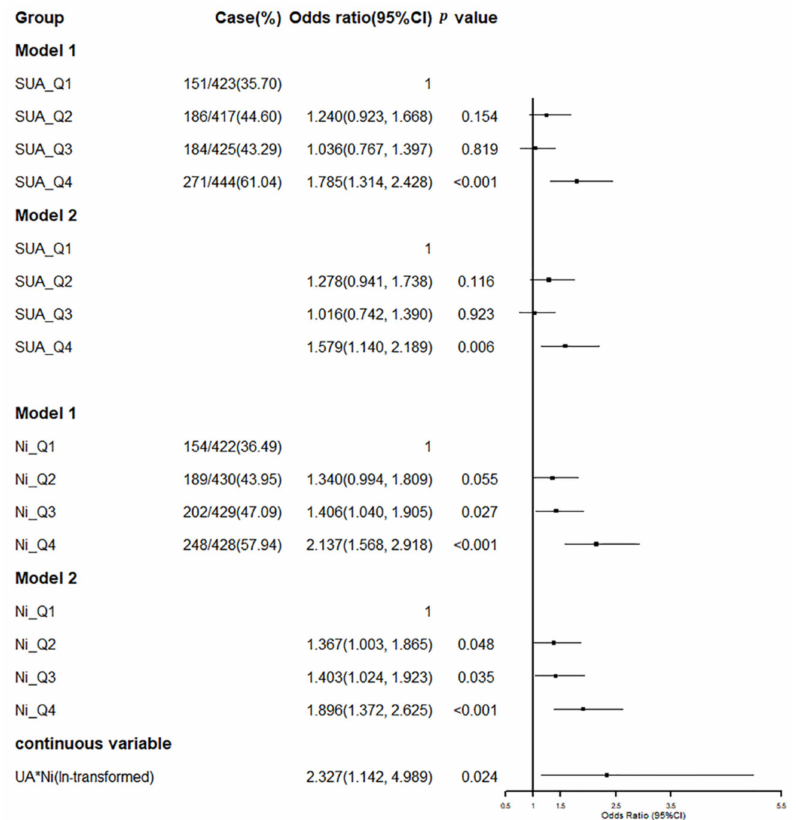
Figure 2. Binary logistic regression analysis of the association between SUA and serum Ni with NAFLD. The SUA quartiles were as follows: <275, 275–322, 322–379 and ≥ 379 µ mol/L. The serum Ni quartiles were as follows: <2.03, 2.03–2.53, 2.53–3.53 and ≥ 3.53 µ g/L. Model 1: adjusted for age and BMI; Model 2: further adjusted for SBP, DBP, ALT, AST, ALP, TBIL, TG, LDL-C, HDL-C, fasting glucose, HbA 1C , meat consumption, and vegetable consumption. UA*Ni (ln-transformed): The interaction effect of serum uric acid and serum nickel on NAFLD when both UA and Ni are considered continuous variables